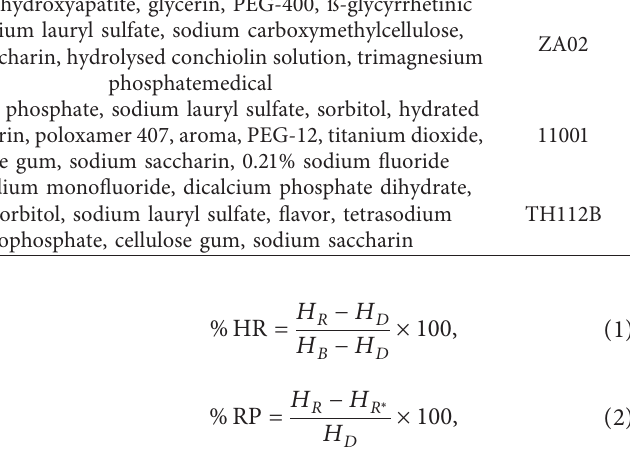
Figure 1: (a) Human second bicuspid was horizontally sectioned at 1mm below cement enamel junction (1). The crown (2) was invested in the acrylic block (3) to create flat surface area (b) of 4 × 4mm 2 . The indentation was performed on the flat surface (4) by diamond indenter at 1mm apart from each other (5) in the microhardness tester (c). The indentation (d) were measured for diagonal length (D1, D2) and calculated for Vicker hardness Table 1: Materials, company, compositions, and batch number of toothpastes used in this study. Materials